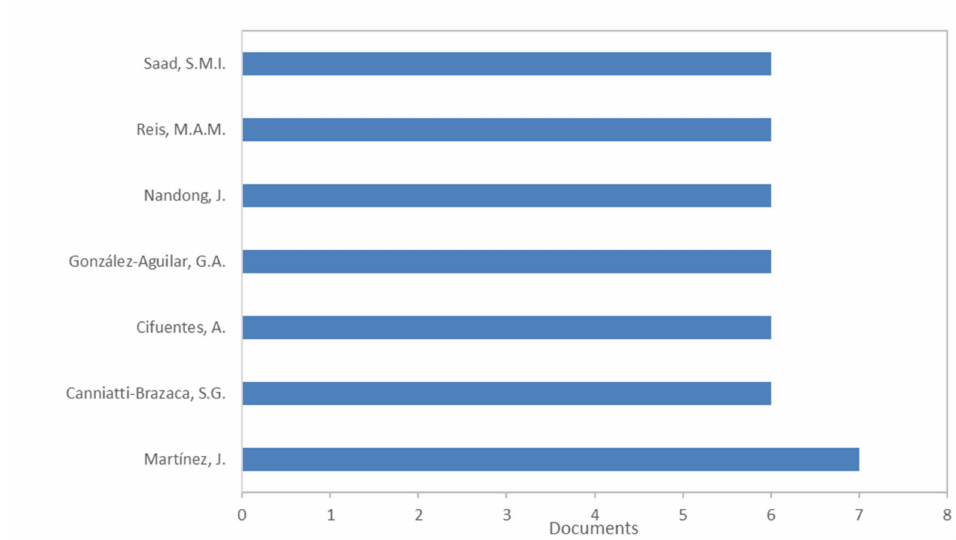
Figure 3. Most productive authors (Bibliometric data were extracted from the Scopus online database).